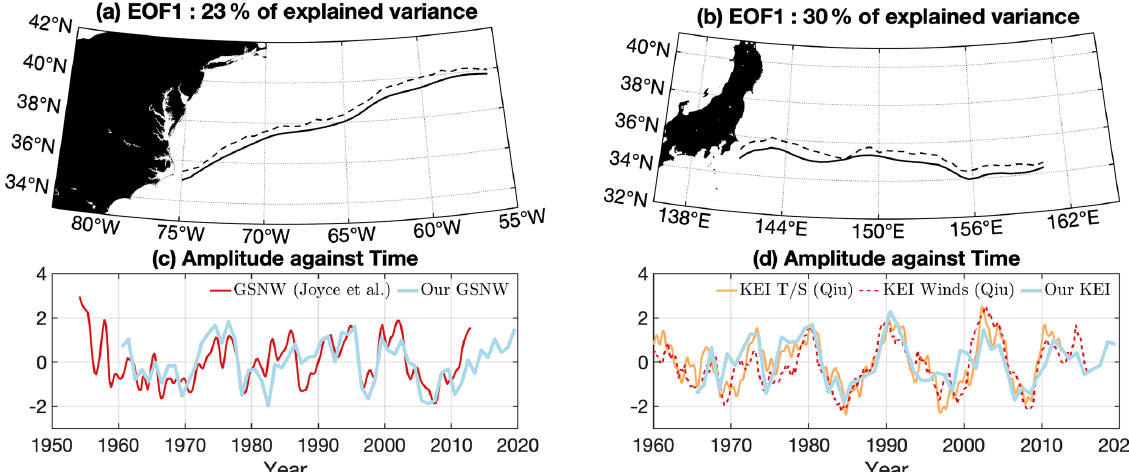
Figure 2. (a) GS climatological position (solid line) and GS climatological position plus GSNW spatial amplitude based on EOF analysis of the along-jet temperature anomalies (dashed line). Conversion ratio from normalized temperature to latitude is arbitrarily set for visualization but is the same at every grid point. (c) GSNW time series obtained from EOF analysis (thick light blue), with the GSNW index of Joyce et al. (2000) also shown in red. Panels (b) and (d) are as for (a) and (c) but obtained for the Kuroshio Extension and with the KE indices of Qiu et al. (2016) replacing Joyce et al. (2000). The solid orange line in (d) corresponds to the temperature- and salinity-based index, and the dashed thin red line corresponds to the wind-based index. All time series in (c) and (d) are